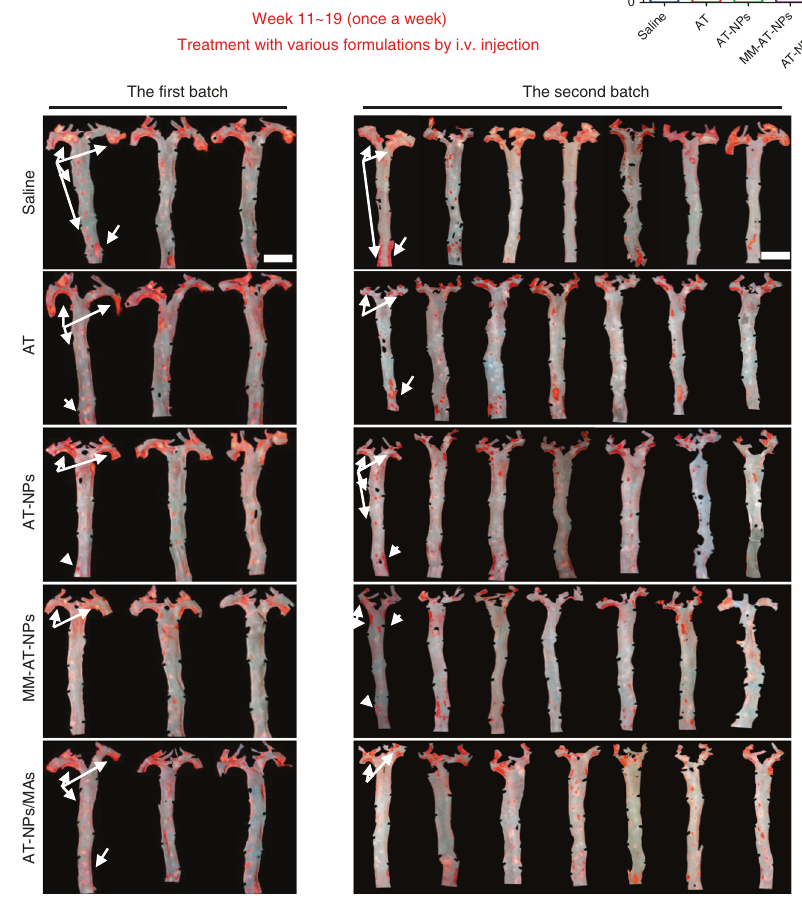
Treatment with various formulations by i.v.